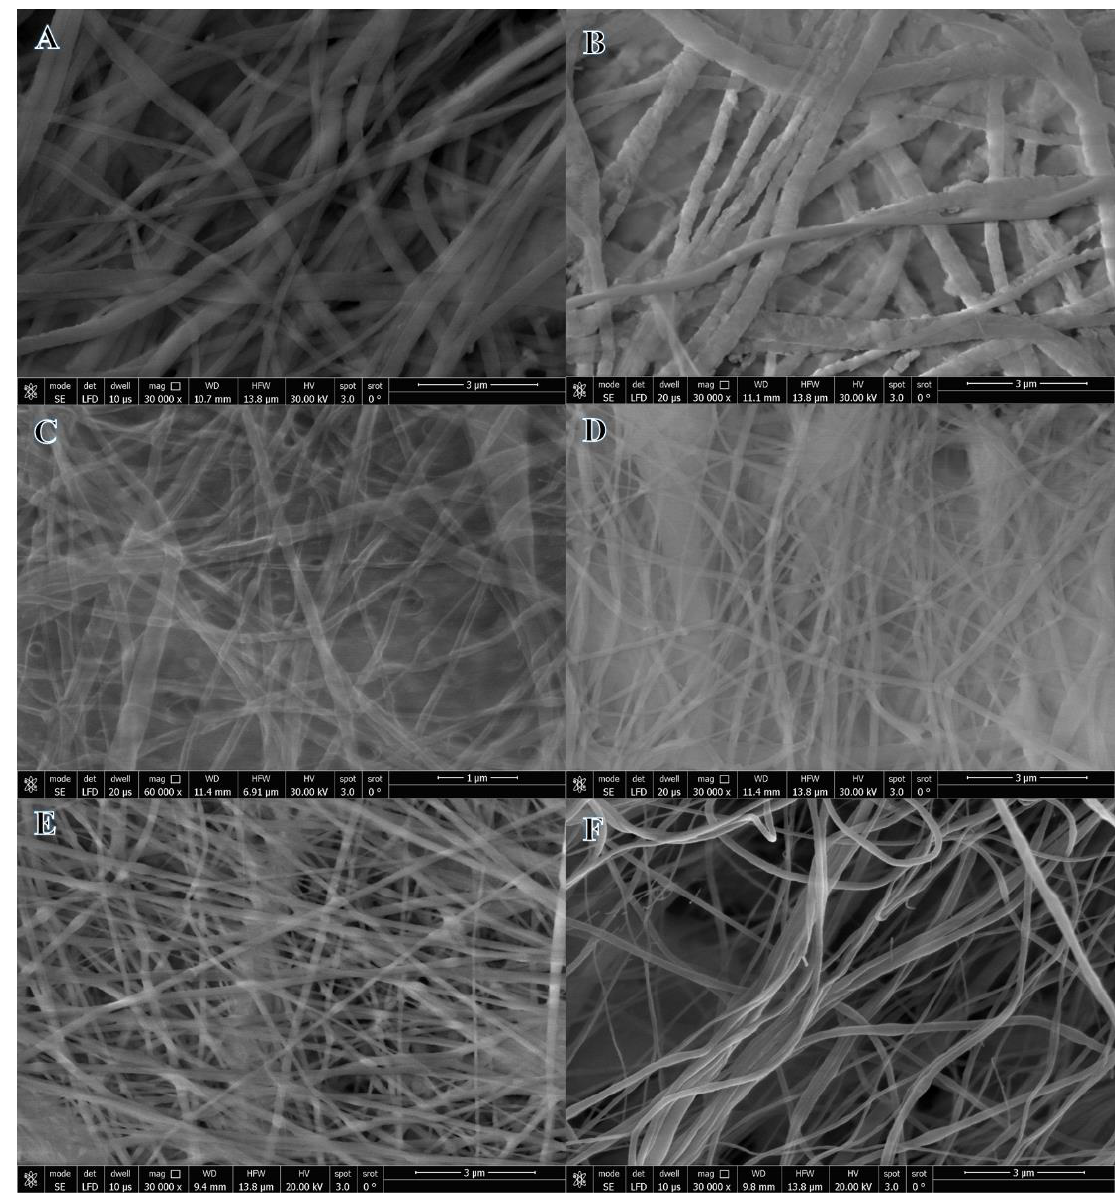
Figure 1. SEM images of PVDF-HFP ( A ), Ni@PVDF-HFP ( B ), Ni 95 Pd 5 @PVDF-HFP ( C ), Ni 90 Pd 10 @PVDF-HFP ( D ), Ni 85 Pd 15 @PVDF-HFP ( E ), and Ni 75 Pd 25 @PVDF-HFP NFs membrane ( F The EDX of Ni 75 Pd 25 @PVDF-HFP membrane NFs is revealed in Figure 2. It is evident that the chemical makeup of the product comprises of carbon, fluorine, nickel, and palladium elements. The percentage weight of the elements is shown in the inset of Figure 2.